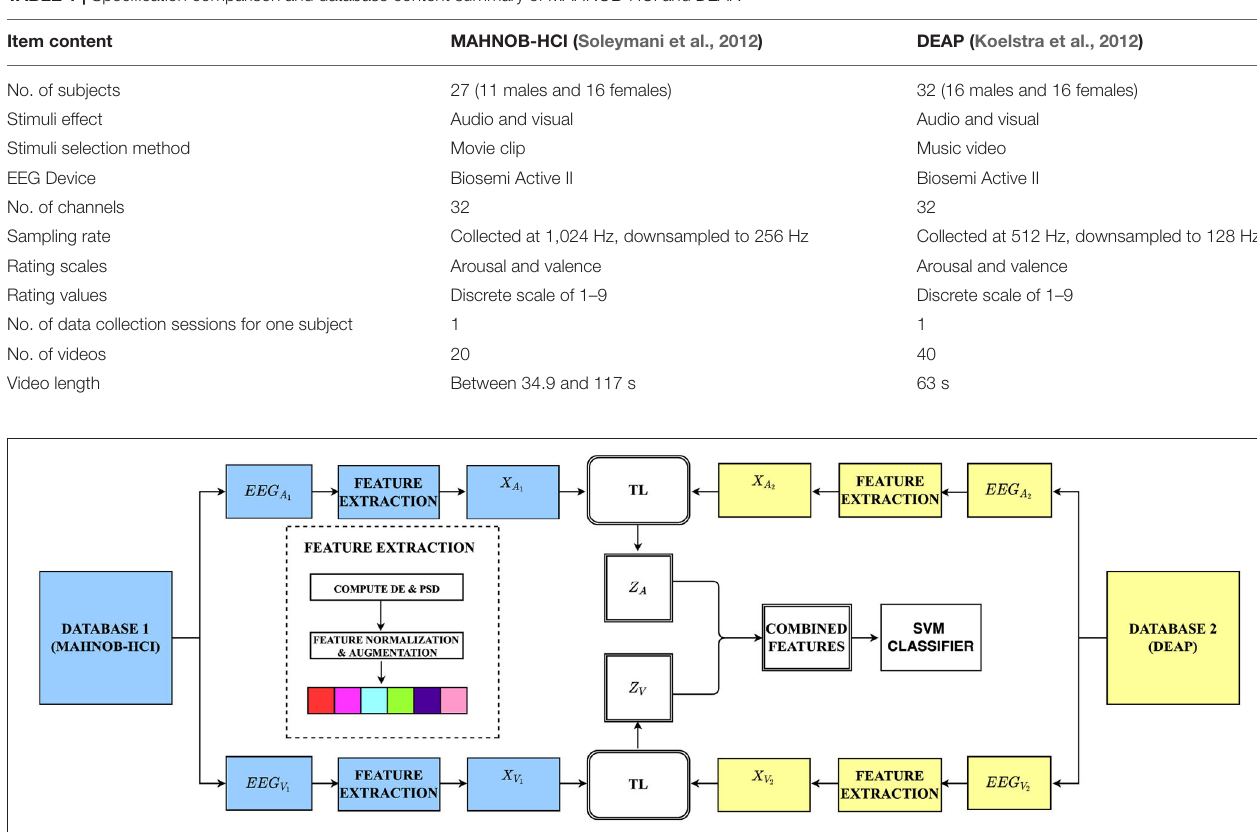
TABLE 1 | Specification comparison and database content summary of MAHNOB-HCI and DEAP.